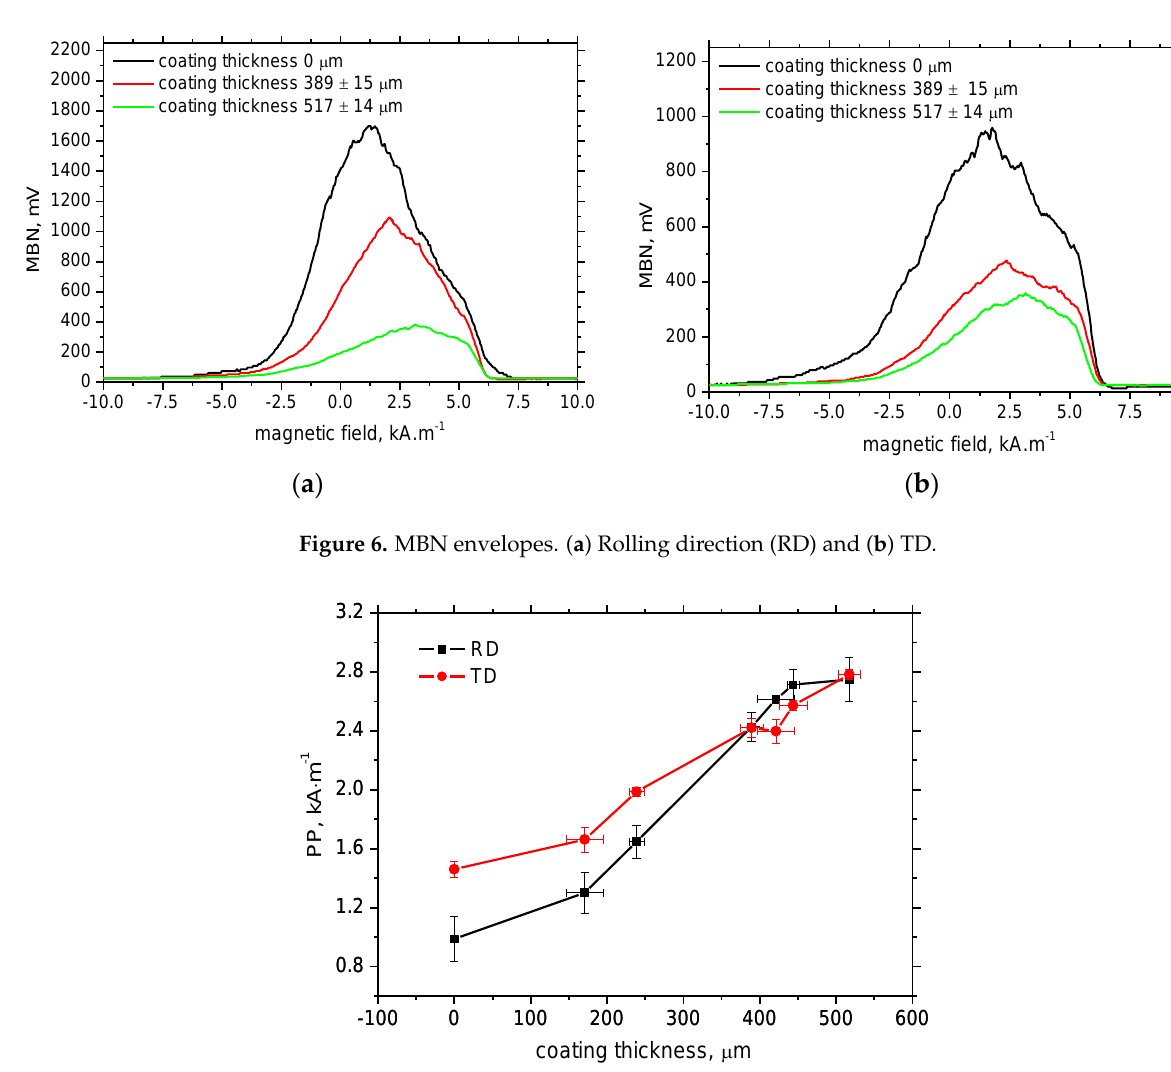
Figure 7. Coating thickness (obtained from the LM observations) versus peak position ( PP ).